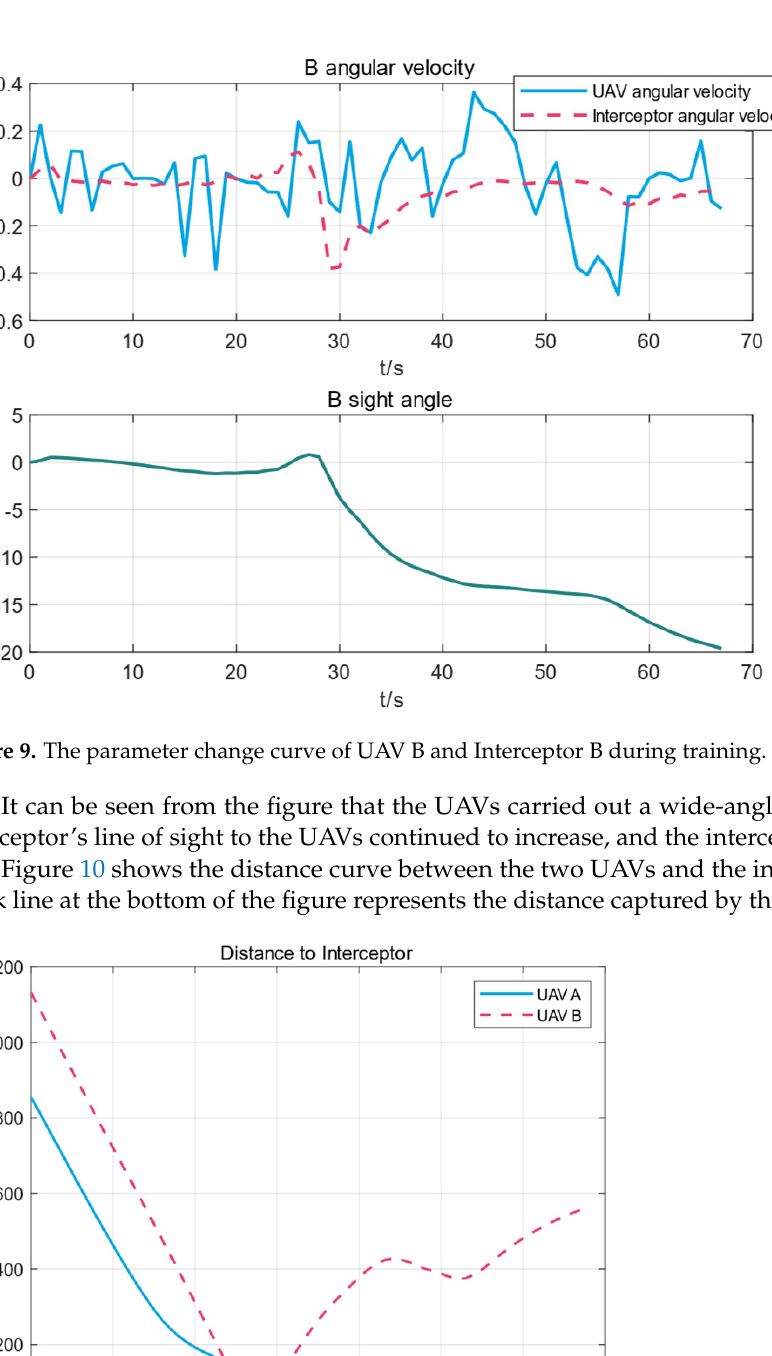
Figure 8. The parameter change curve of UAV A and Interceptor A during training.